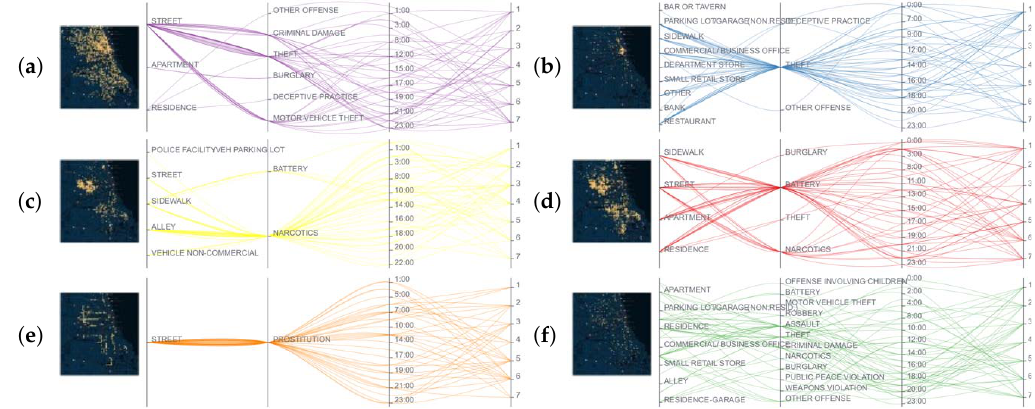
Figure 11. ( a – f ) Six representative patterns identified using our approach. . Participants : We recruited 20 participants (12 males and 8 females, aged 22–25).